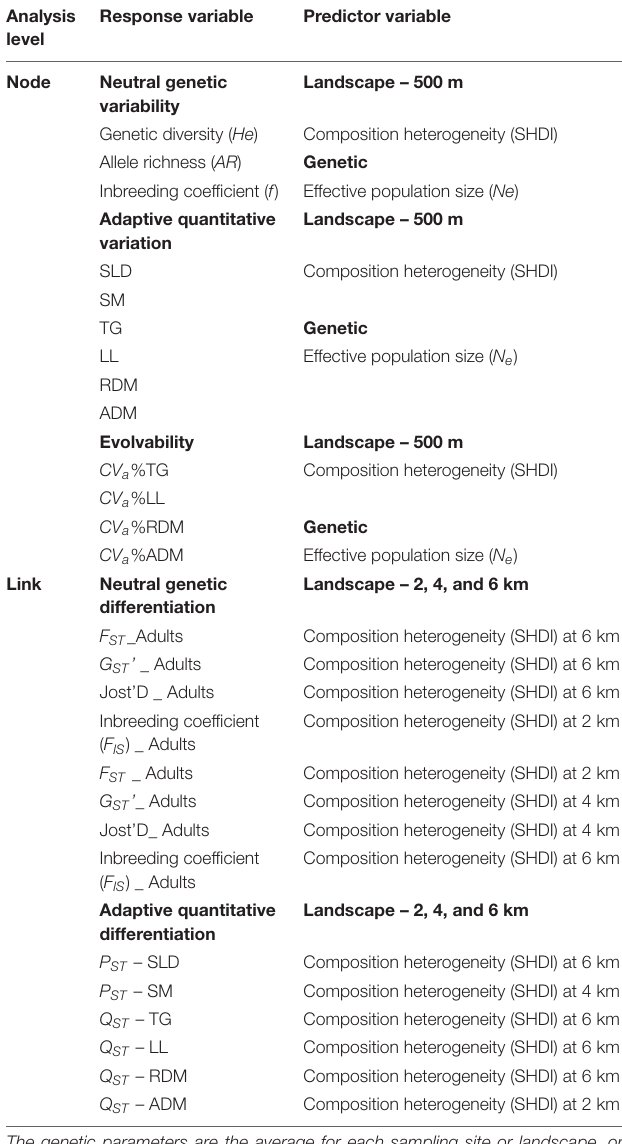
TABLE 1 | Models performed at node and link levels for both neutral and adaptive quantitative traits measured in seeds and seedlings of Caryocar brasiliense